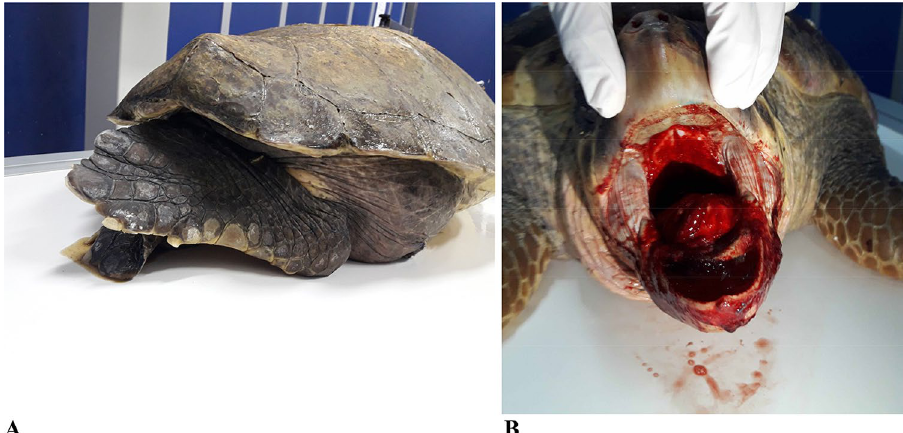
Figure 3. ( A ) Hind limbs flexed under the carapace in a turtle with GE; ( B ) turtle with blood coming from the oral cavity arising from the larynx that died 6 h after arriving at the STC (11 h after trawling).